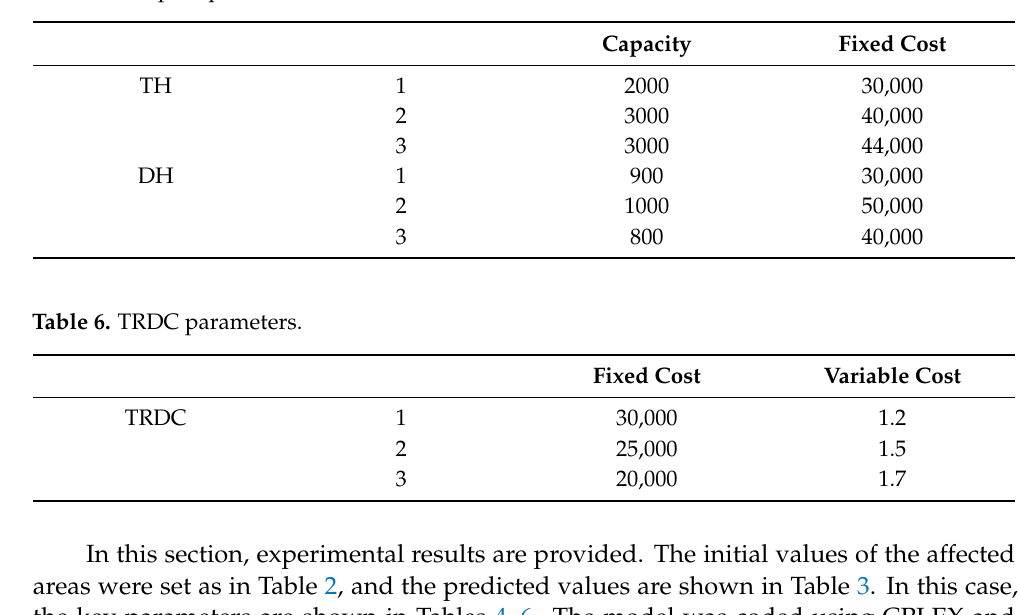
Table 5. Hospital parameters.